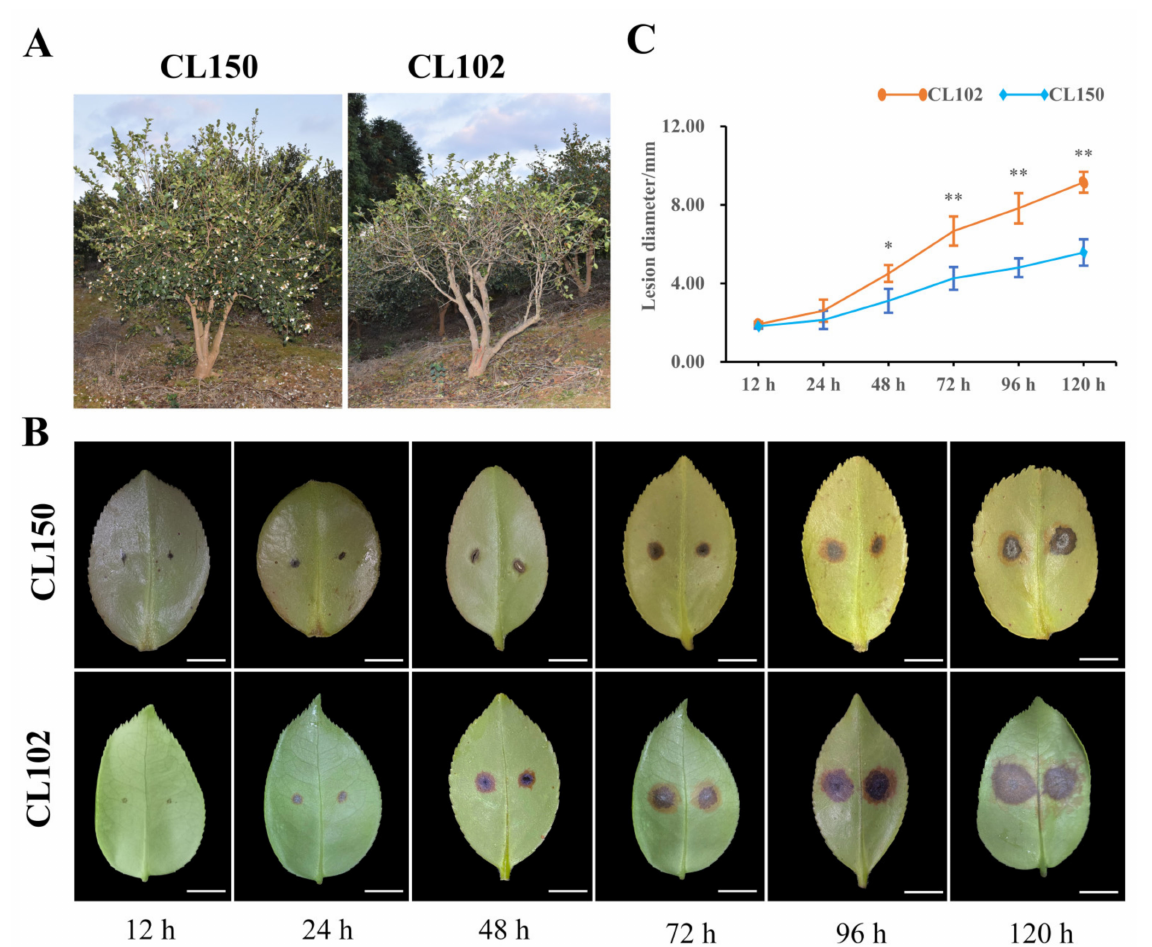
Figure 1. ( A ) Growth of CL150 and CL102 in the field. ( B ) Phenotype of CL150 and CL102 after inoculation with Co. gloeosporioides , Scale bar = 1 cm. ( C ) Leaf lesion size over time of CL150 and CL102 after inoculation with Co. Gloeosporioides , n = 12; “*” and “**” indicate significant differences at p < 0.05 and p < 0.01,